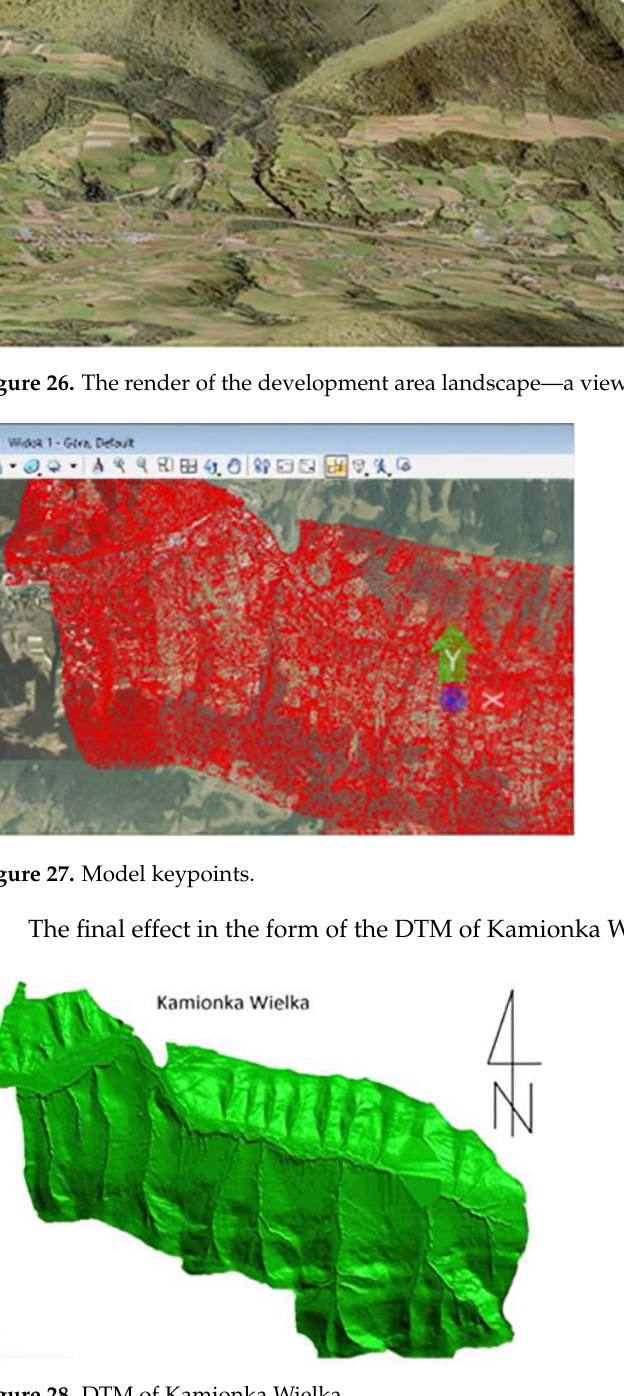
Figure 28. DTM of Kamionka Wielka.